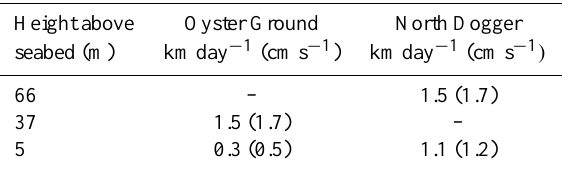
Table 7. Net average daily advection rates between May and September 2007, calculated from ADCP data. The actual net resid- ual over the 120 day stratified period is less than the daily average.